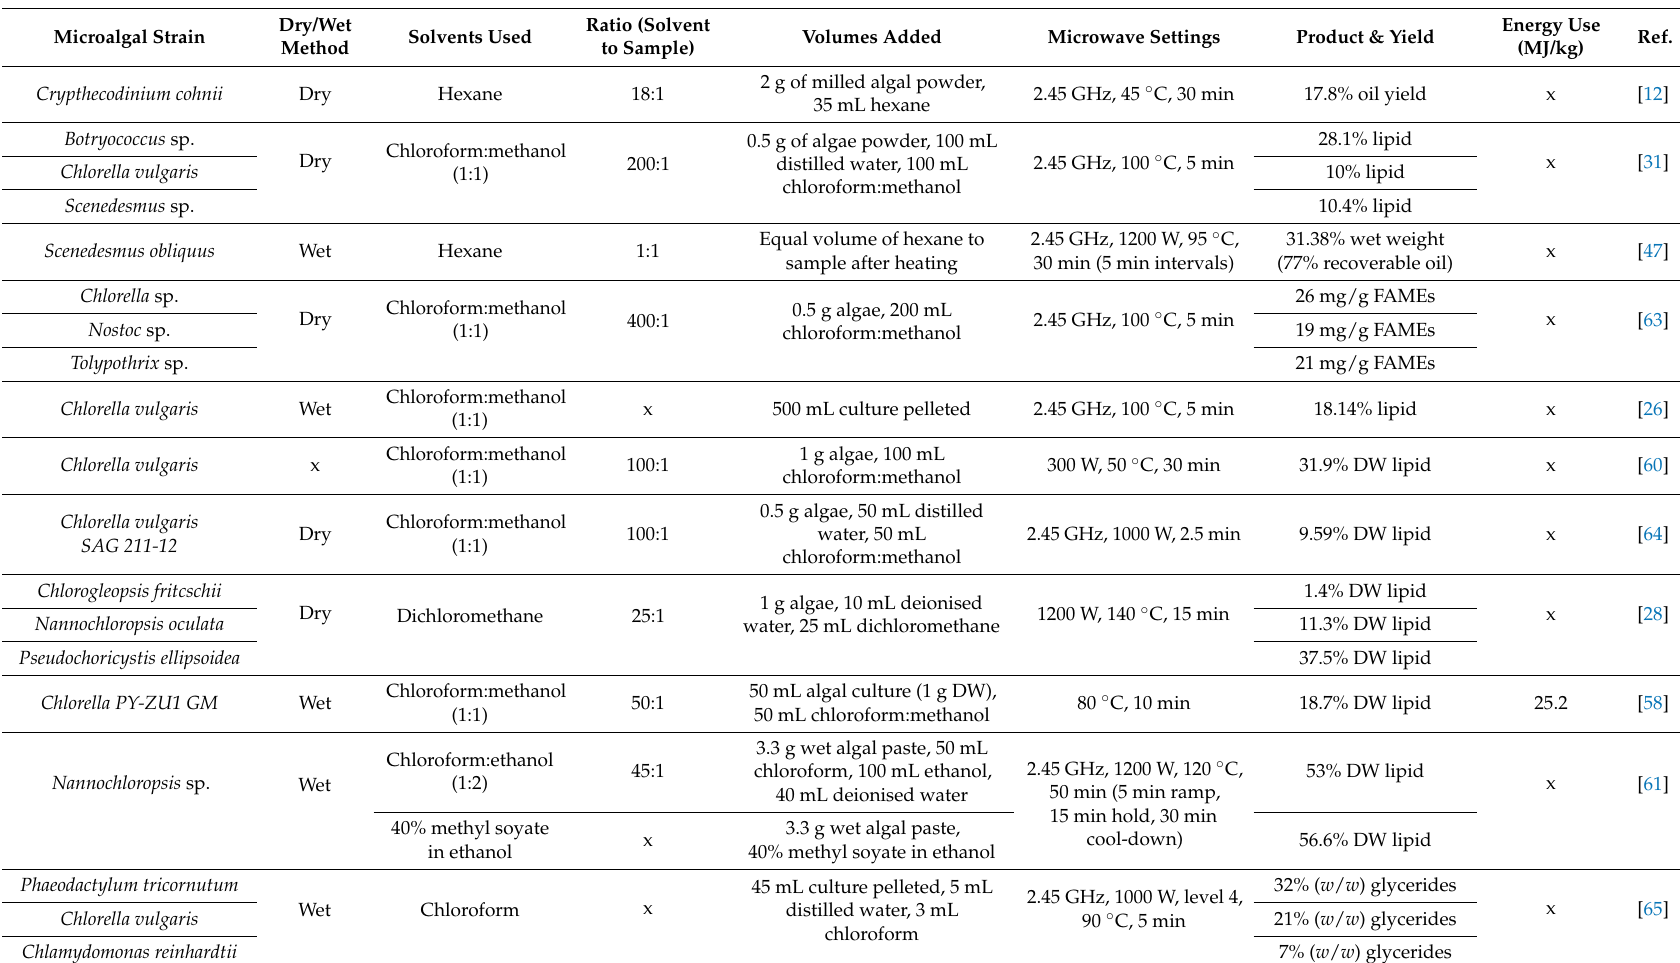
Table 2. Lipids extracted from microalgae by MAE as a pre-treatment